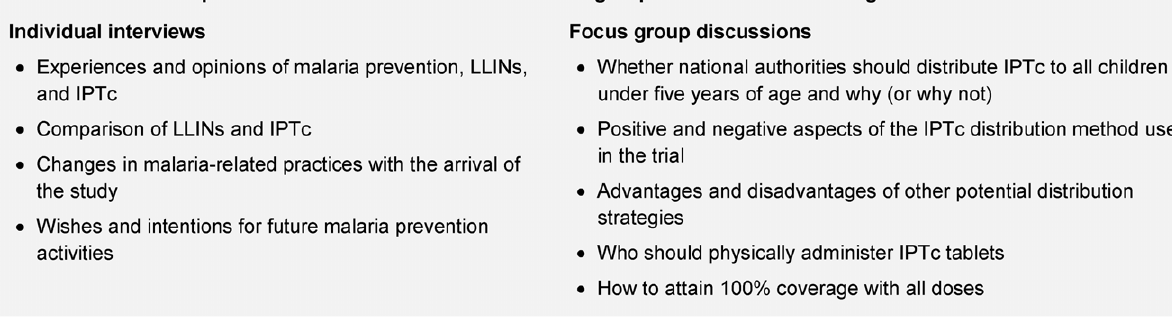
Figure 1. Themes explored in individual interviews and focus group discussions with caregivers and CHWs.